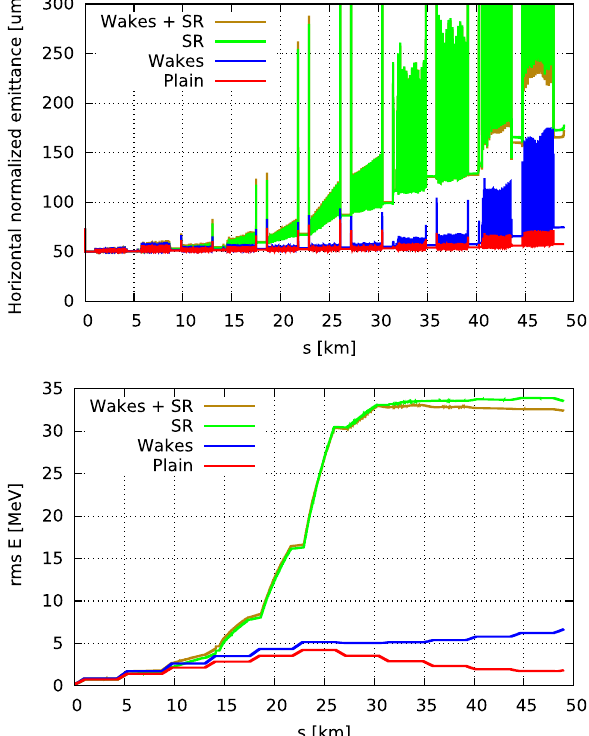
FIG. 10. Horizontal emittance and energy rms of a bunch tracked from the injector to the dump with an initial horizontal offset of 1 mm. The blowups caused by synchrotron radiation and wakefields are compared. The emittance includes the dispersion contribution; thus, its value in the arcs is not